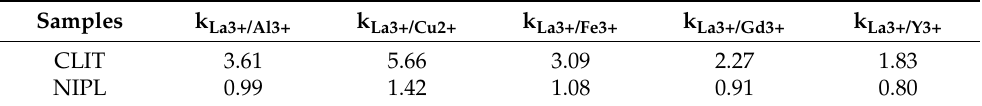
Table 2. Selective adsorption coefficients k of CLIT and NIPL in solution containing six ions (contain- ing Al 3+ , Cu 2+ , Fe 3+ , Gd 3+ , La 3+ and Y 3+ ). Samples k